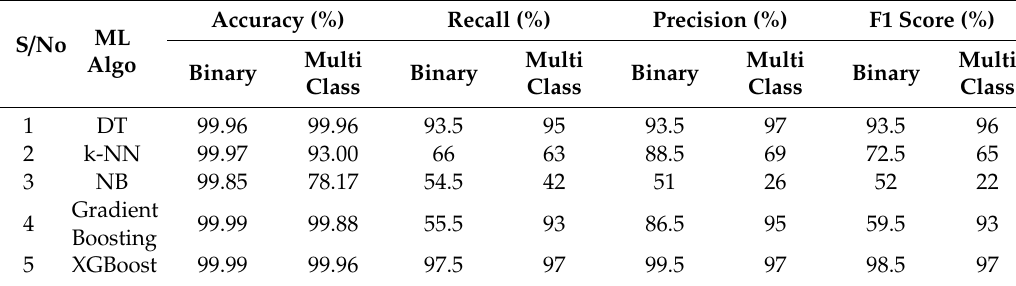
Table 12. Summary of binary and multiclass